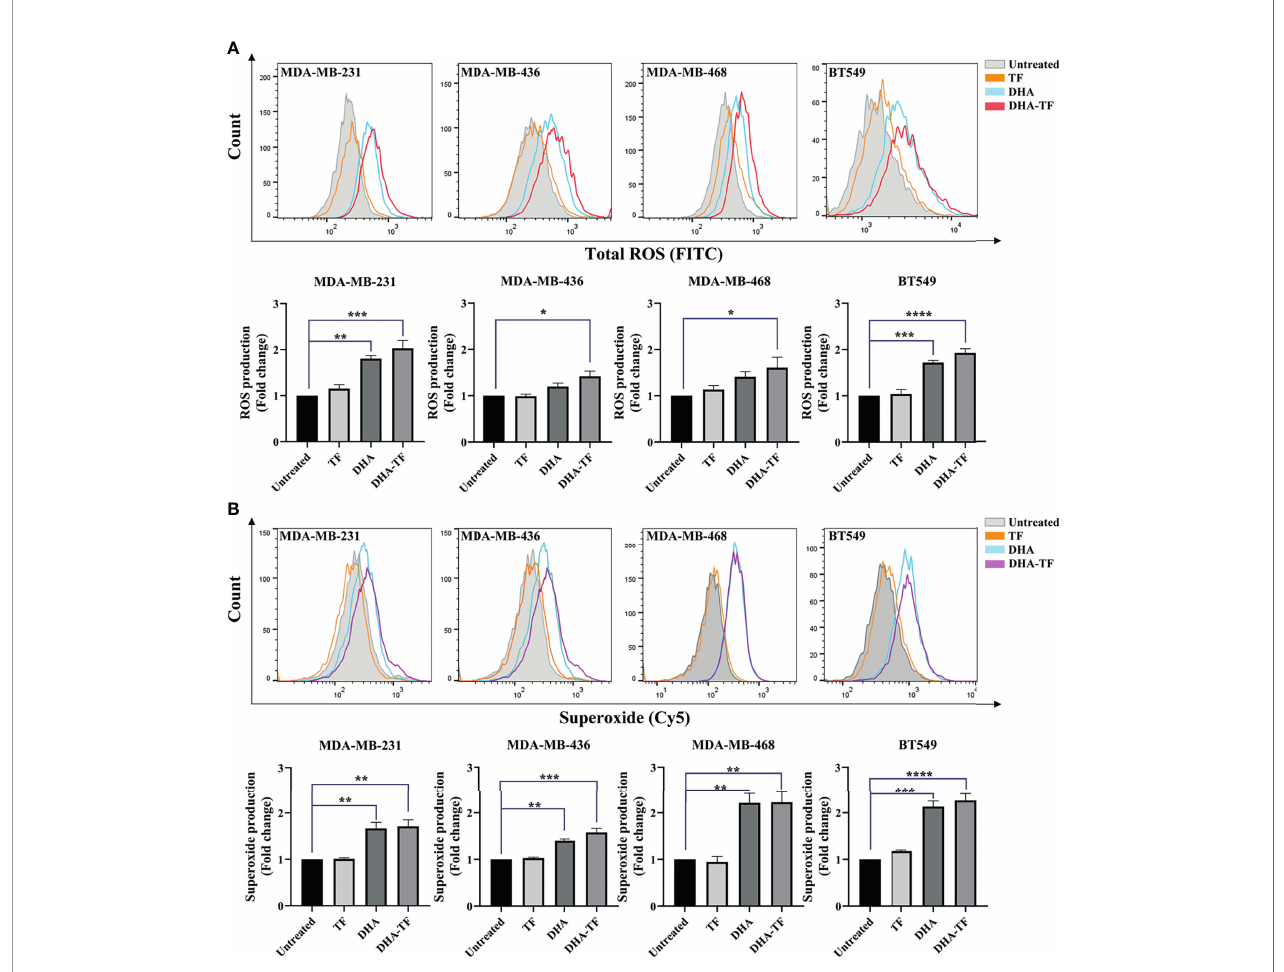
FIGURE 2 | ROS and superoxide are produced by DHA and DHA-TF in TNBC cells. Total ROS (A) and superoxide (B) production were detected in MDA-MB-231, MDA-MB-436, MBA-MD-468, and BT549 cells under different treatment for 20 h. Results are quanti fi ed as fold changes of ROS or superoxide production under the treatments relative to untreated group in bar graphs. Data shown are mean ± SEM from three independent experiments performed in triplicate. *0.01 < p ≤ 0.05, **0.001 < p ≤ 0.01, ***0.0001 < p ≤ 0.001, ****p ≤